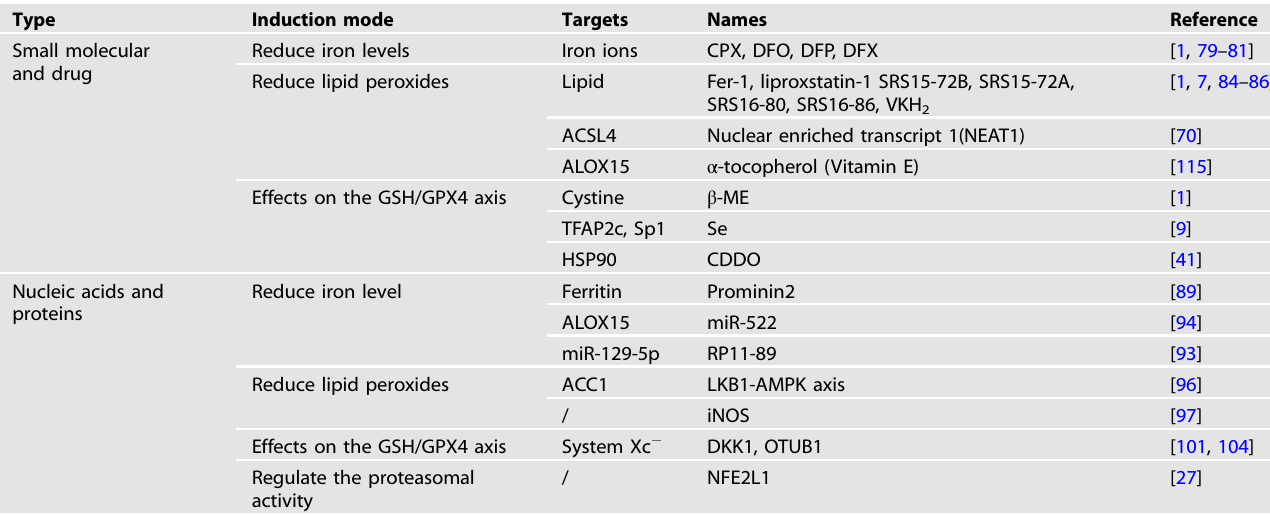
Table 2. Examples of ferroptosis